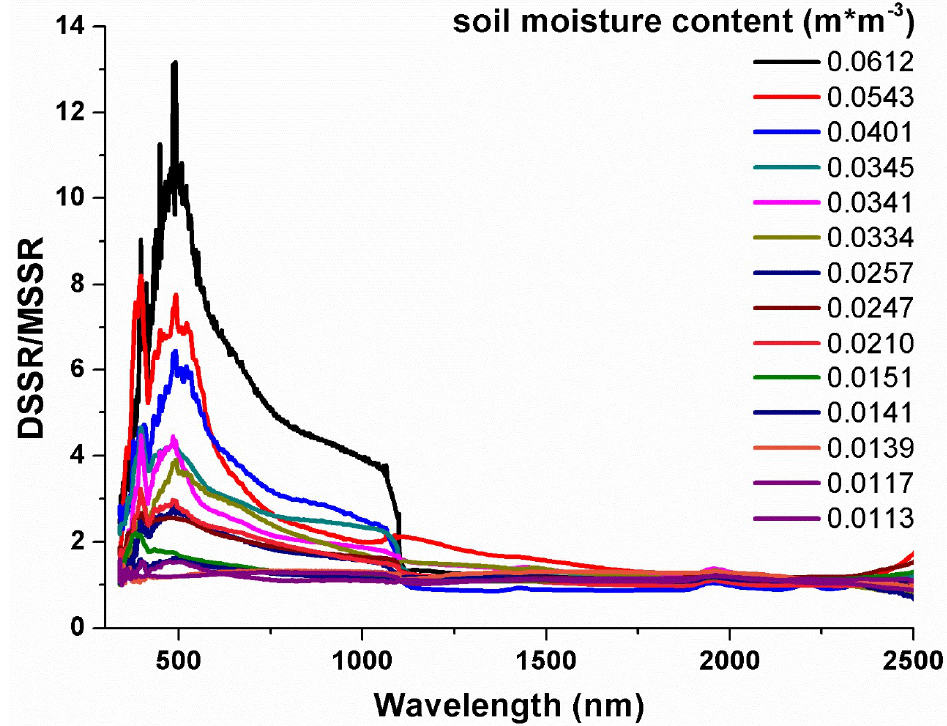
Figure 9. The spectral ratio of dry soil spectral reflectance (DSSR) to moisture soil spectral reflectance (MSSR) plotted against wavelength at different levels of soil moisture.